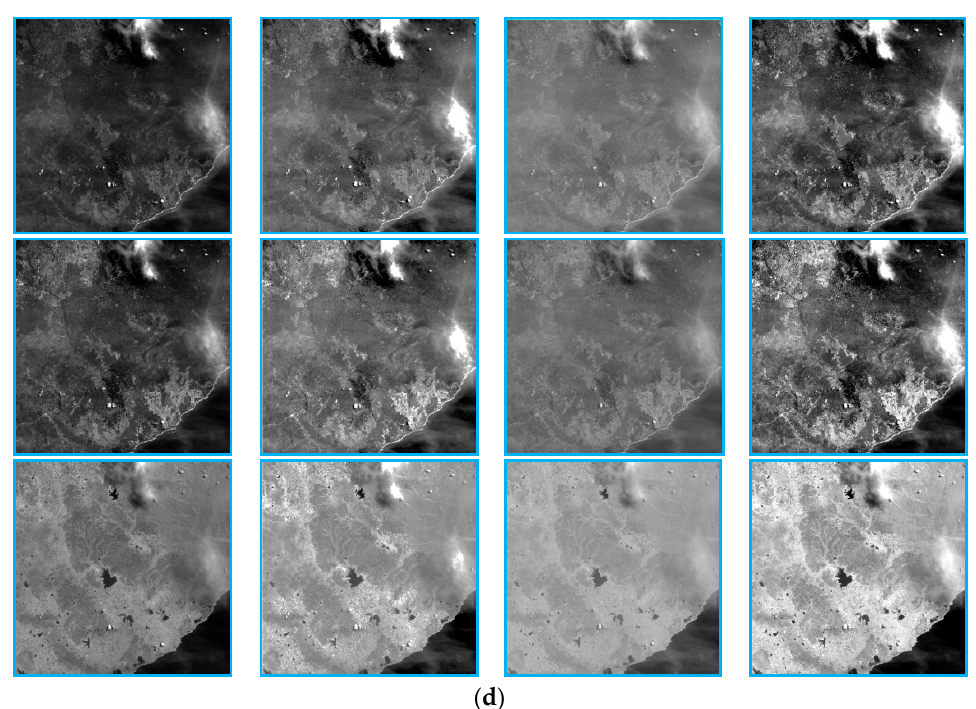
Figure 11. Image enhancement effect: ( a ) short coastline image enhancement; ( b ) long coastline image enhancement; ( c ) multiple coastlines image enhancement; and ( d ) cloud-shielded coastline image enhancement. Table 1. Short coastline image quality.